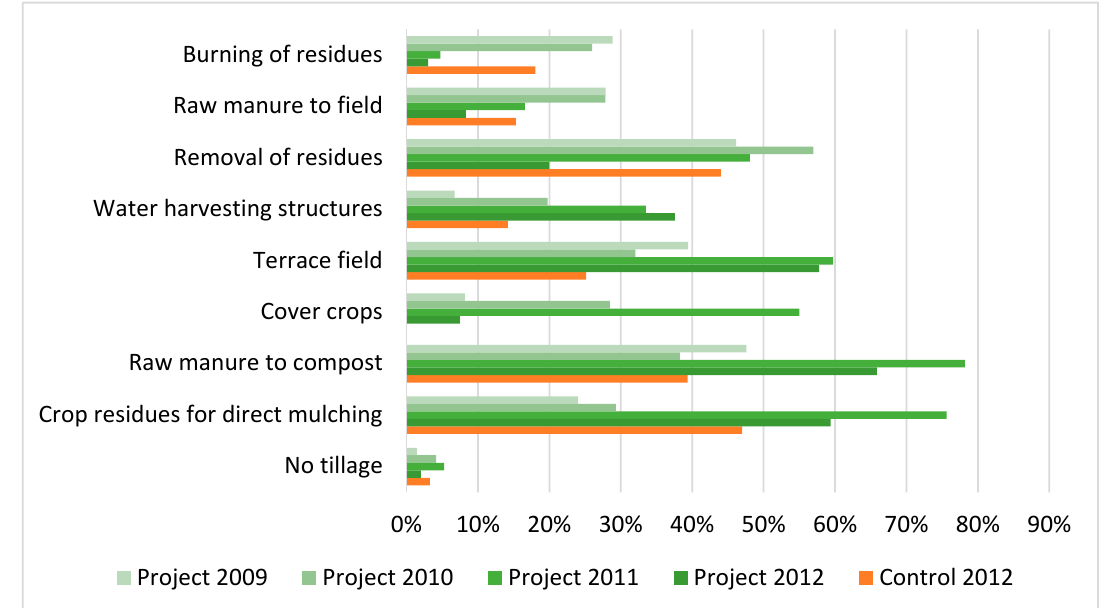
Figure 3. Diagram showing SALM uptake and implementation in fields in the two areas of Kisumu and Bungoma by project farmers and control farmers between 2009 (project start) and 2012. Data for control groups only available for 2012. Data for project farms in Kisumu in 2009 were lost due to a computer malfunction. N = 183 for control 2012, n = 208 for project 2009, n = 481 for project 2010, n = 591 for project 2011 and n = 495 for project 2012.